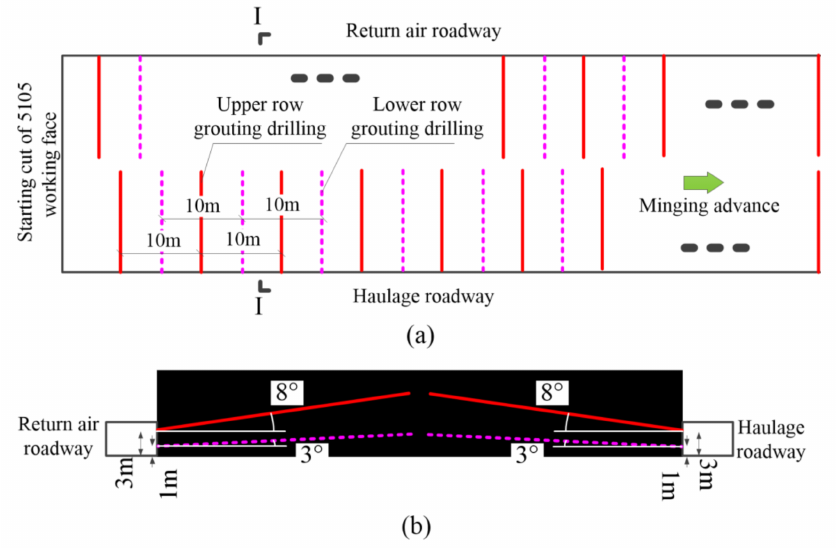
Figure 8. Scheme of drilling wells for injection of a cement slurry into a coal seam. ( a ) Vertial view; ( b ) I-I